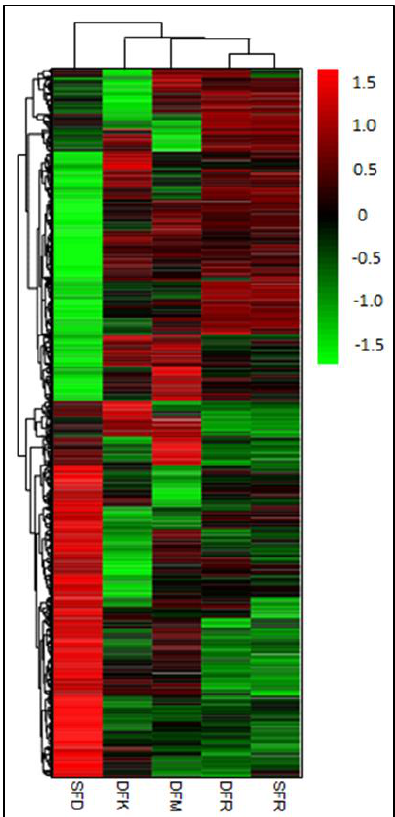
Figure 2. Heat map illustrating the expression profiles of differentially expressed genes (DEGs) between all sample comparisons in apple single and double flower varieties.